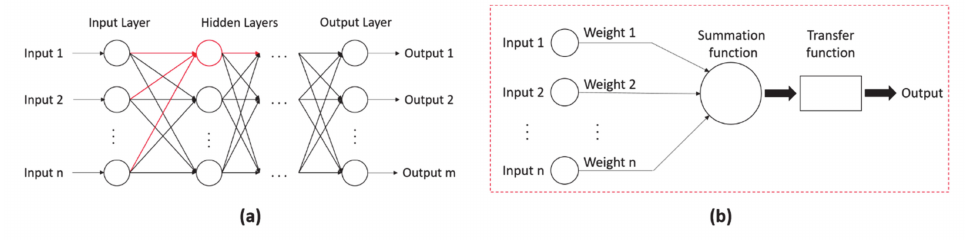
Figure 2. Schematical view of a feedforward neural network ( a ) and detail view of a neuron ( b